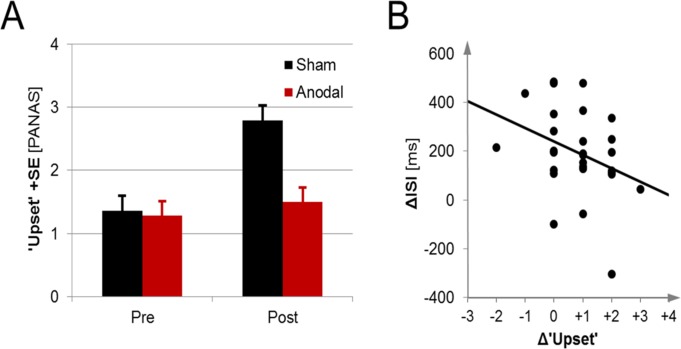
Feeling ‘upset’ and processing speed.Whereas participants in the sham stimulation group felt more upset after the experiment, this increase was alleviated in the anodal stimulation group (Panel A). Increase in feeling upset was correlated with less processing speed improvements as measured by the PASAT inter-stimulus interval (ISI; Panel B). Error bars represent standard errors of the mean.